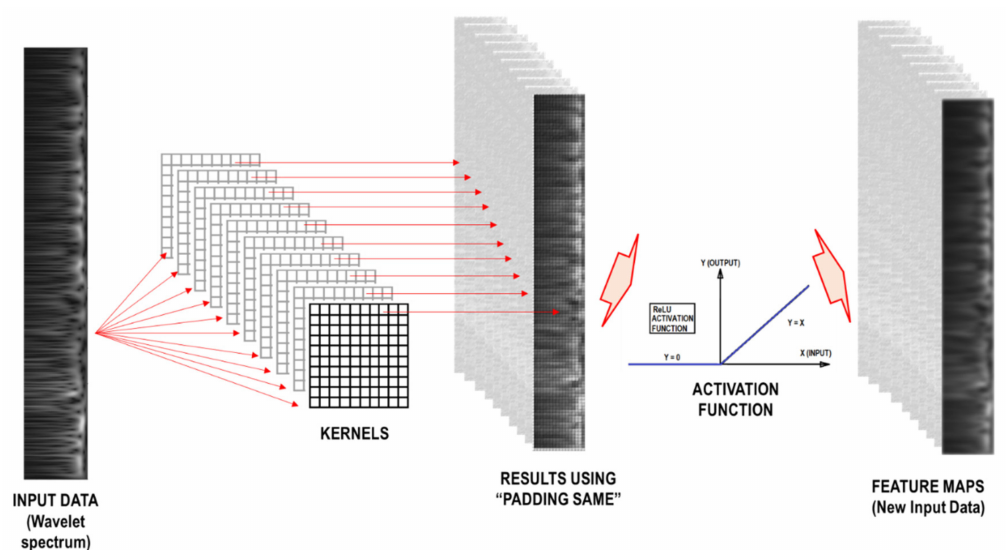
Figure 12. Typical convolutional layer, note that the input data is a representation of the wavelet coefficient’s